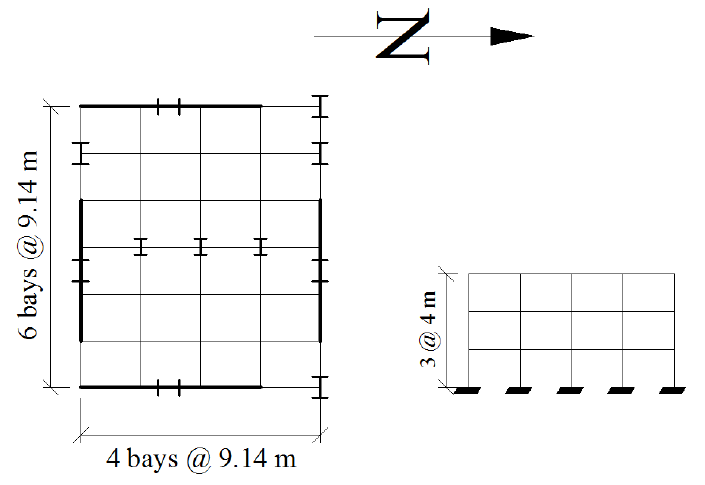
Figure 1. Elevation for Model1 .